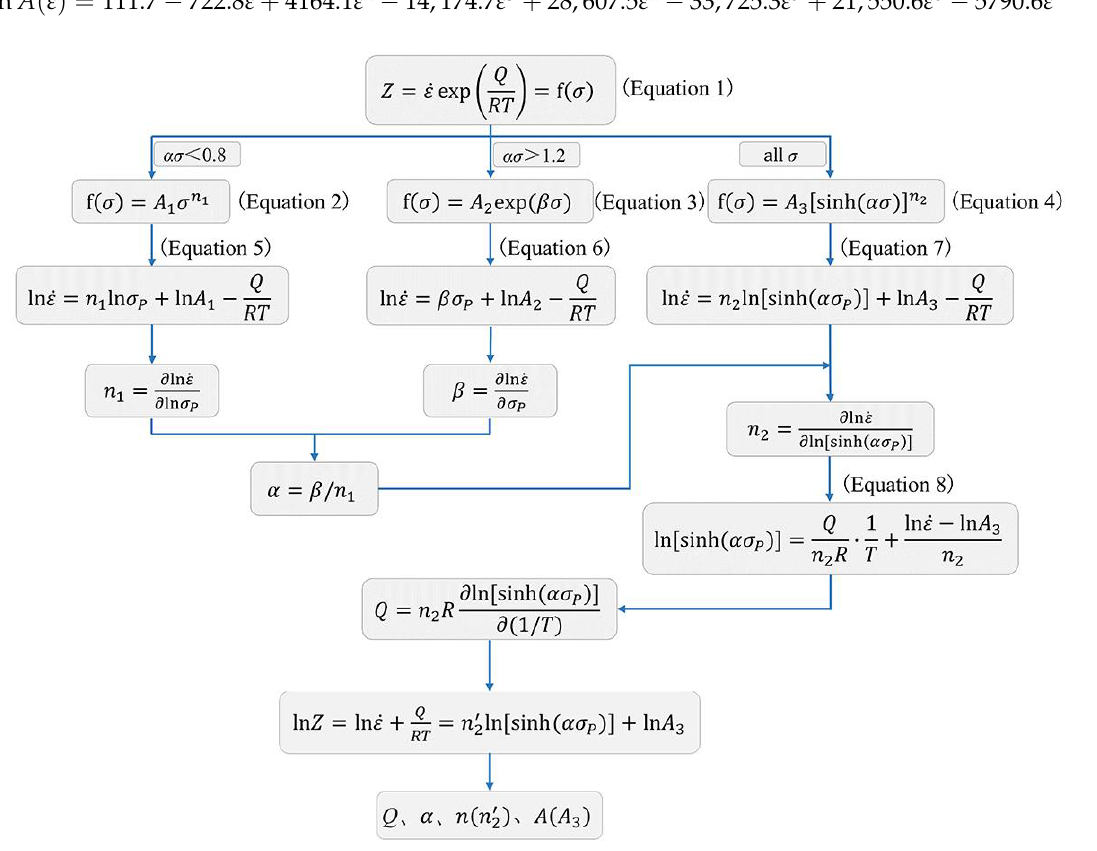
Figure 4. The calculation flow chart of the material-dependent constants related to the constitutive equation.